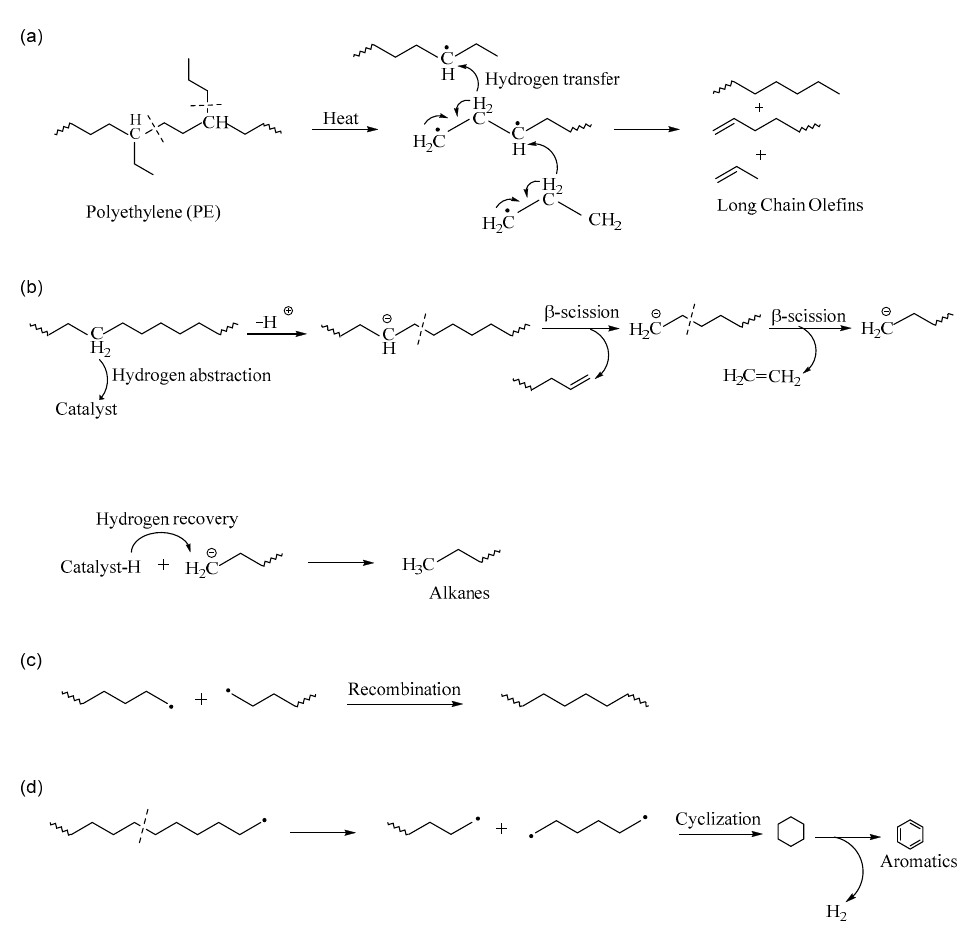
Figure 2. Reaction mechanism involved for the noncatalytic and catalytic pyrolysis of polyethylene present in landfill liners. ( a ) free radical chain scission and hydrogen transfer to form olefins; ( b ) hydrogen abstraction and β -scission followed by chain termination through proton recovery; ( c ) free radical chain termination through recombination to form long chain alkanes; ( d ) chain scission followed by cyclization and dehydrogenation to form